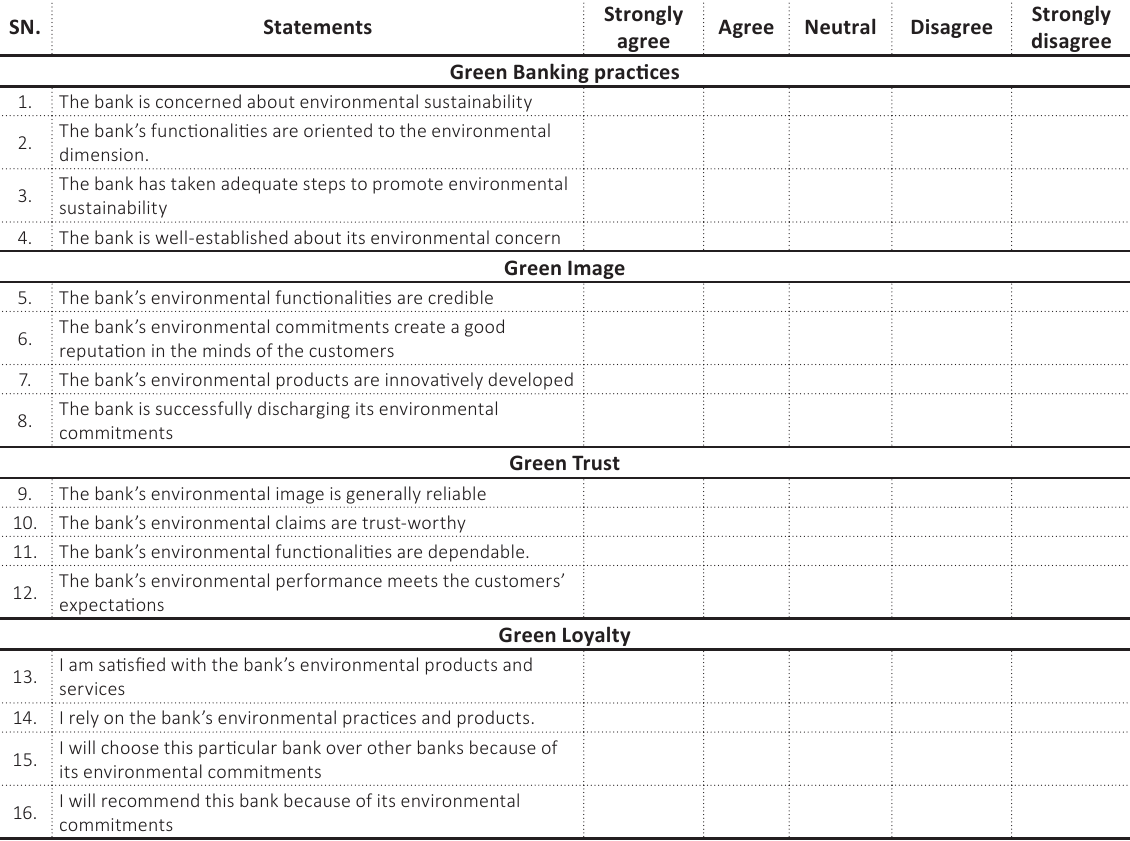
Table A1. Rate the following statements regarding the bank’s sustainable environmental initiatives